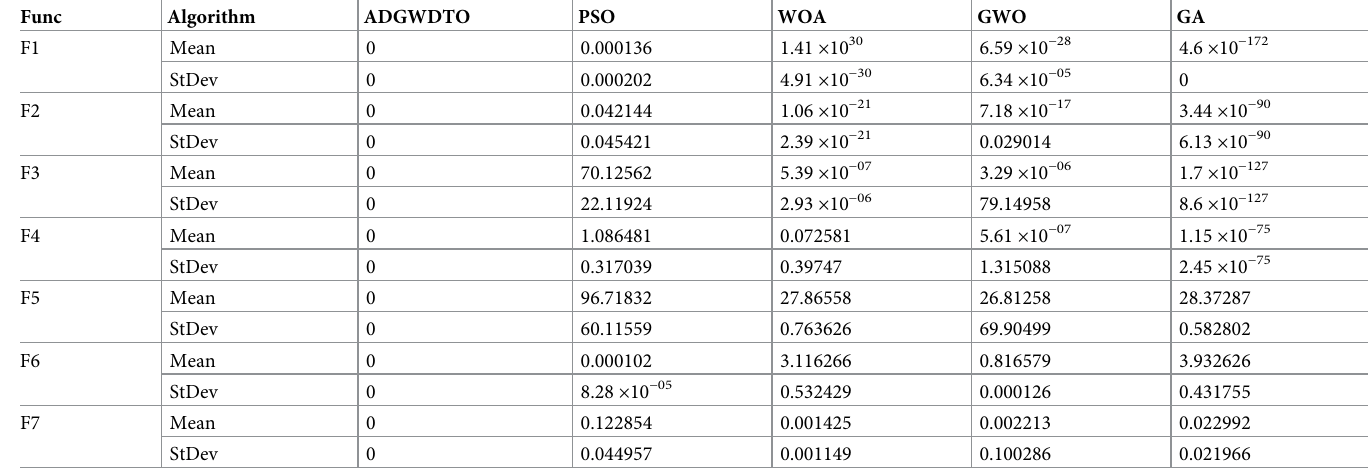
Table 12. Proposed algorithm mean and standard deviation (StDev) versus compared algorithms for the benchmark